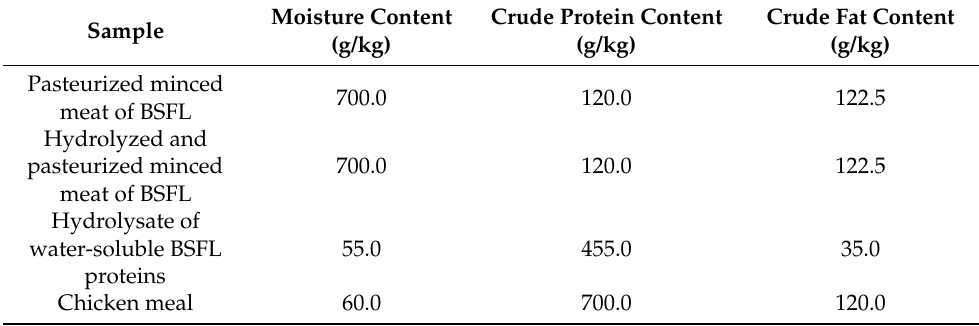
Table 2. Proximate composition of BSFL protein derivatives and chicken meal as indicated by supplier (as in